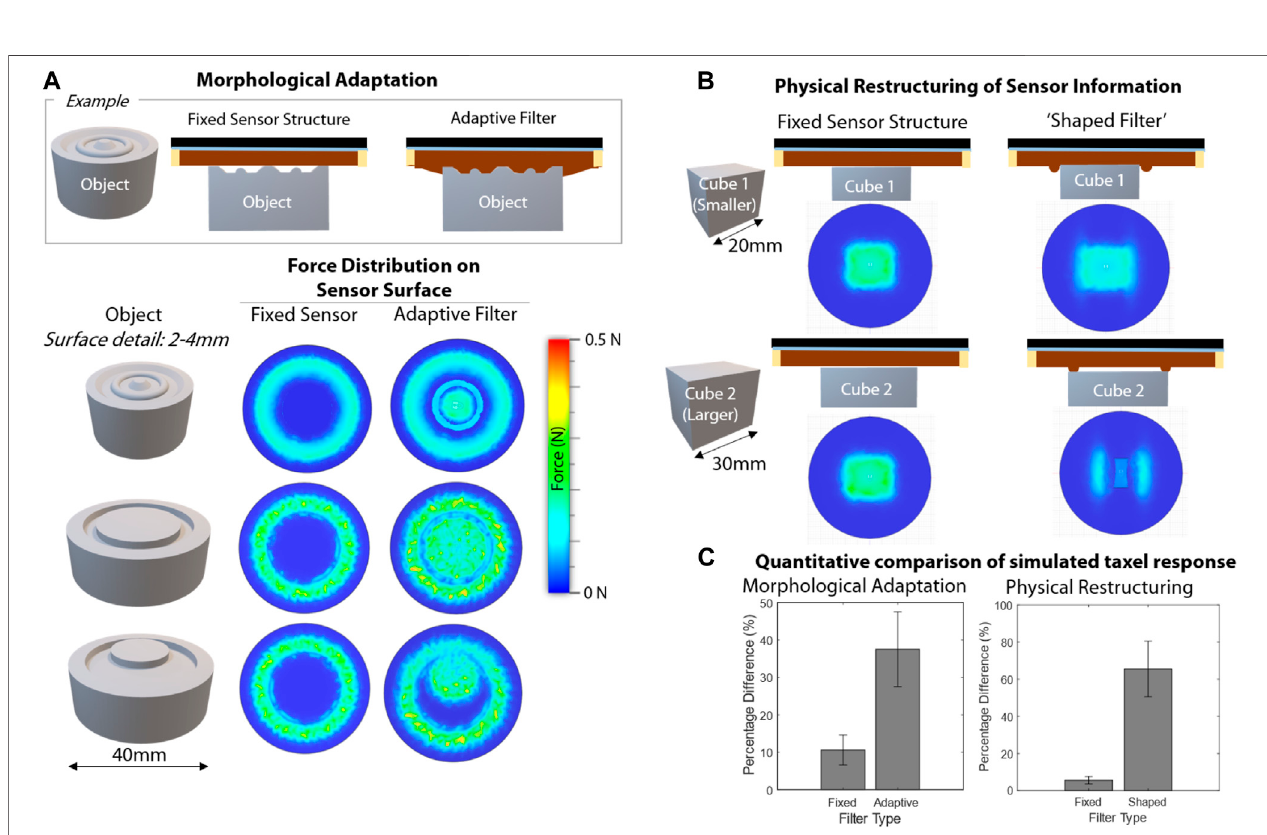
FIGURE 2 | Illustration of the advantages offered by the adaptive fi lter showing FEA based simulations of the force pro fi le on the surface of the sensor for (A) morphological adaptation showing a simulation of the force on the sensor surface for the fi xed and adaptive fi lters for various objects with similar structure, but varying surfacedetail, (B) Physicalreconstructingofthesensorinformationforcubesofdifferentsizes,wheuseda fl at fi xedsensor,orashaped fi lter (C) Quantative comparison of the simluated responses, left - the percentage of differences in pixesls for the FEA responses shown in (A) , and right, the difference for thoose shown in (B) .